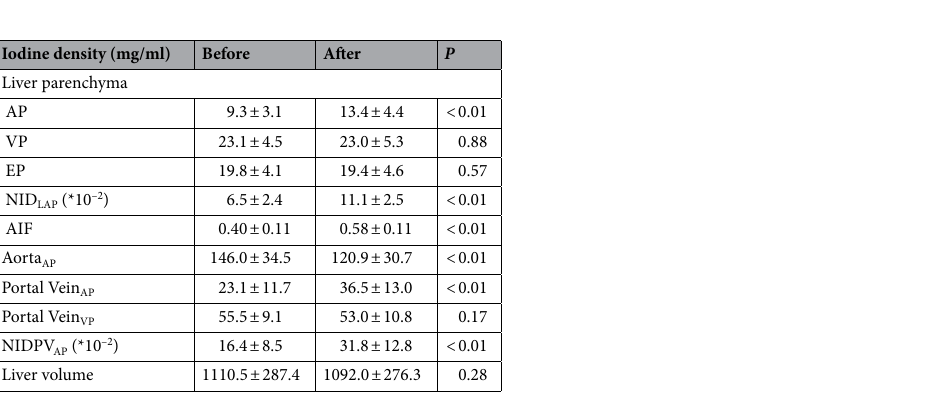
Table 1. Comparisons of Iodine density before and after TIPS. Data are represented as mean ± standard deviation. AP arterial phase, VP venous phase, EP equilibrium phase, AIF liver arterial iodine density fraction, NID LAP normalized iodine density of liver parenchyma in arterial phase, NIDPV AP normalized iodine density of portal vein in arterial phase.